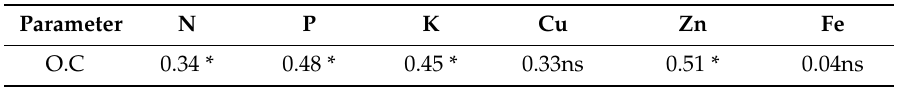
Table 5. Correlation matrix table between organic carbon and key macro and micronutrients in the studied areas.